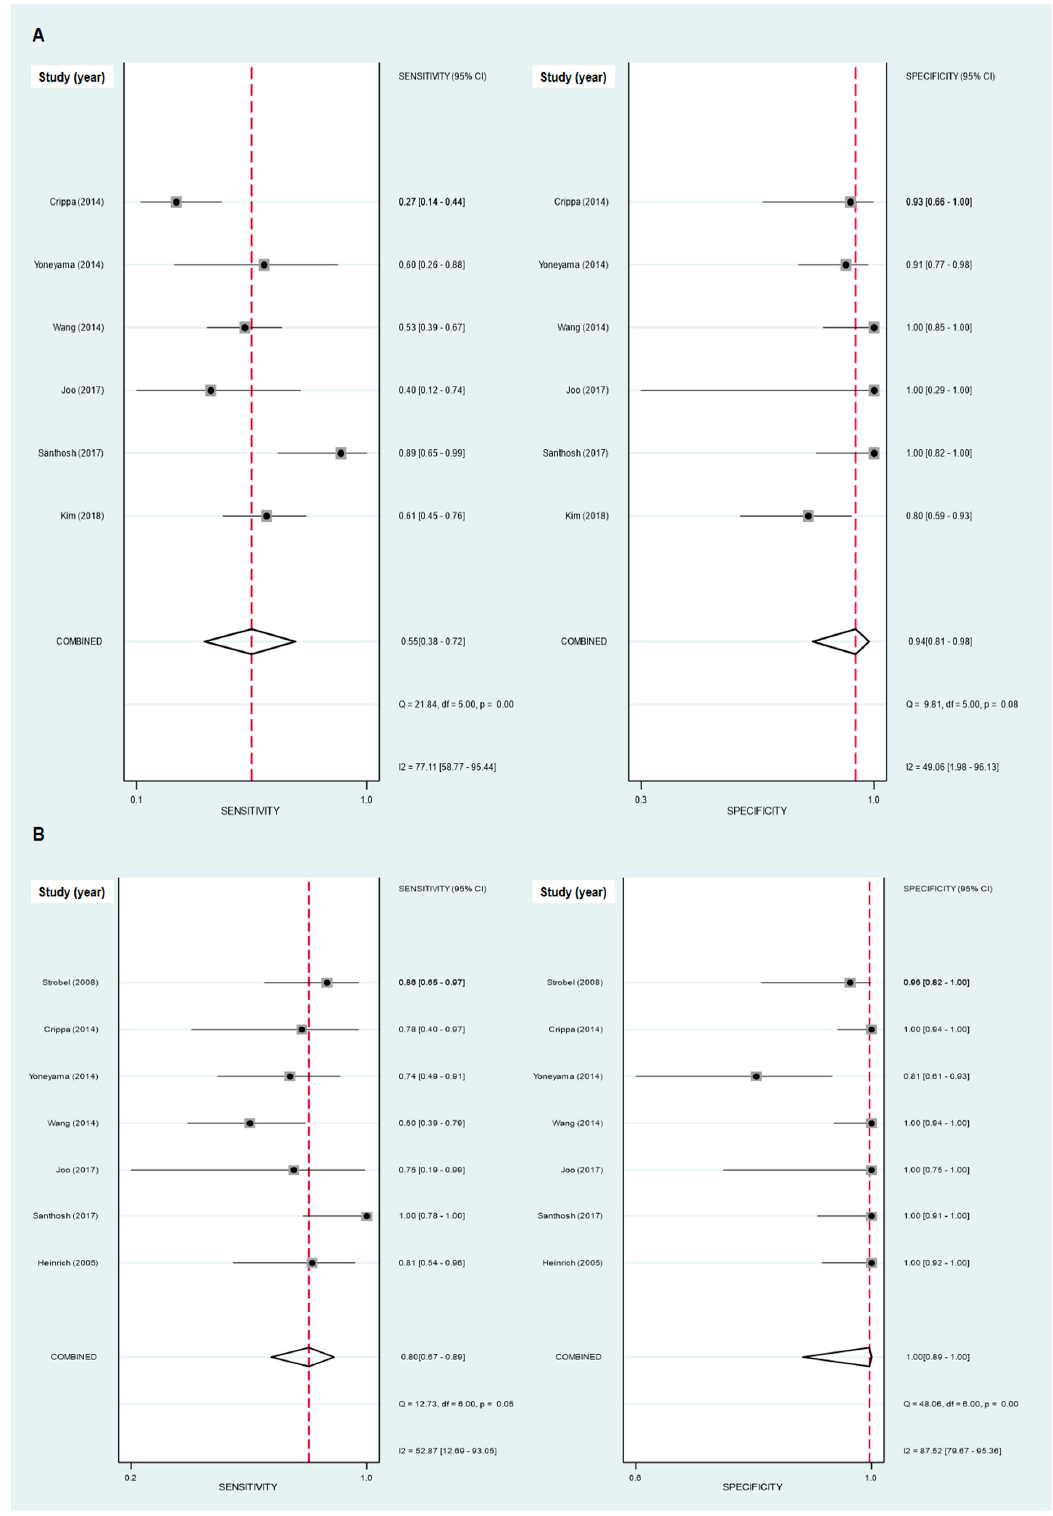
Figure 3. Forest plots of the pooled sensitivity and specificity for detecting lymph node metastasis ( A ) and for detecting distant metastasis ( B ), with 95% confidence intervals. Each solid square represents the sensitivity and specificity of each of the included studies, and the diamond indicates the pooled sensitivity and specificity.